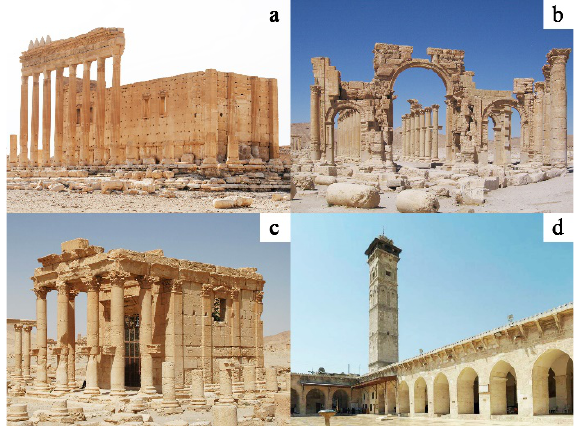
Figure 1. Photos of the three investigated monuments a)